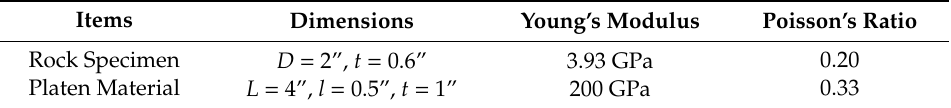
Figure 5. Model mesh. Table 2. Simulation Input